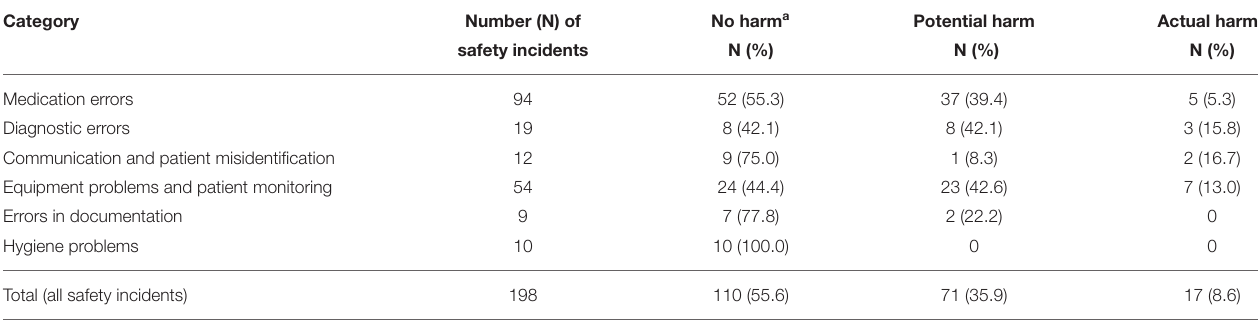
TABLE 2 | Distribution of severity of safety incidents.